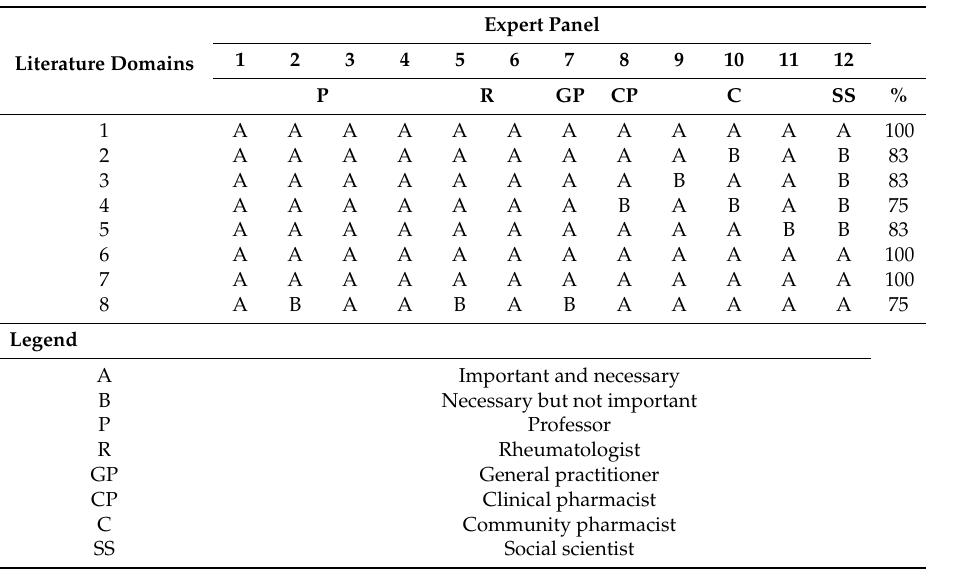
Table 3. Expert panel response to each